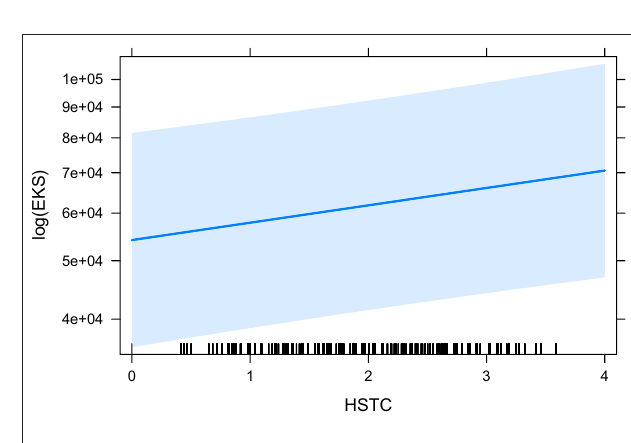
FIGURE 8 | The effect of HSTC on the logarithm of